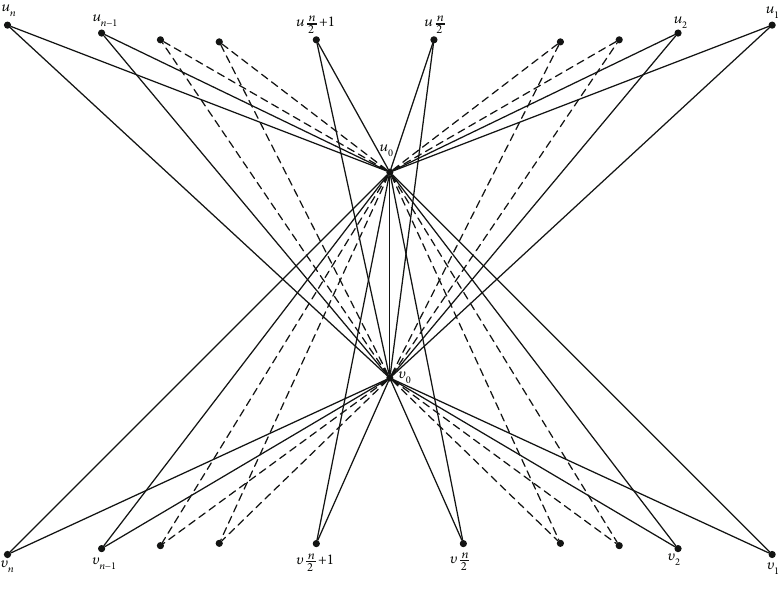
with edge 6 − graceful labeling. 10